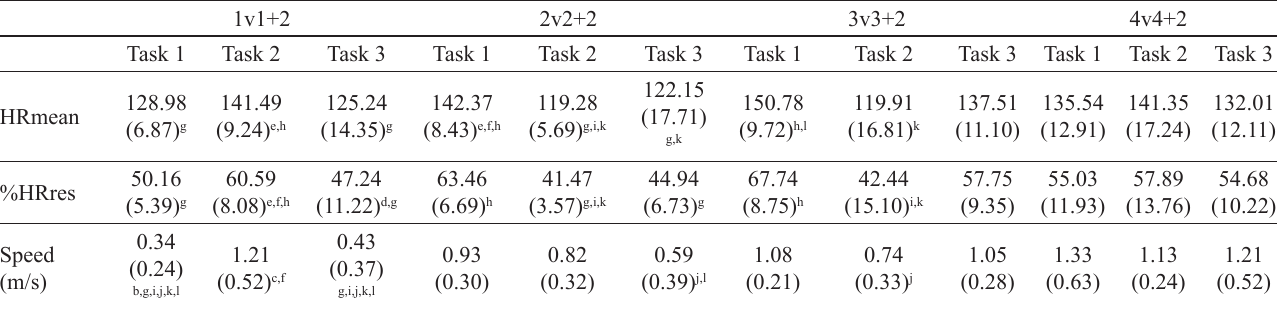
Table 2. Descriptive table (mean and standard deviation) and statistical comparison between crossing factors (game